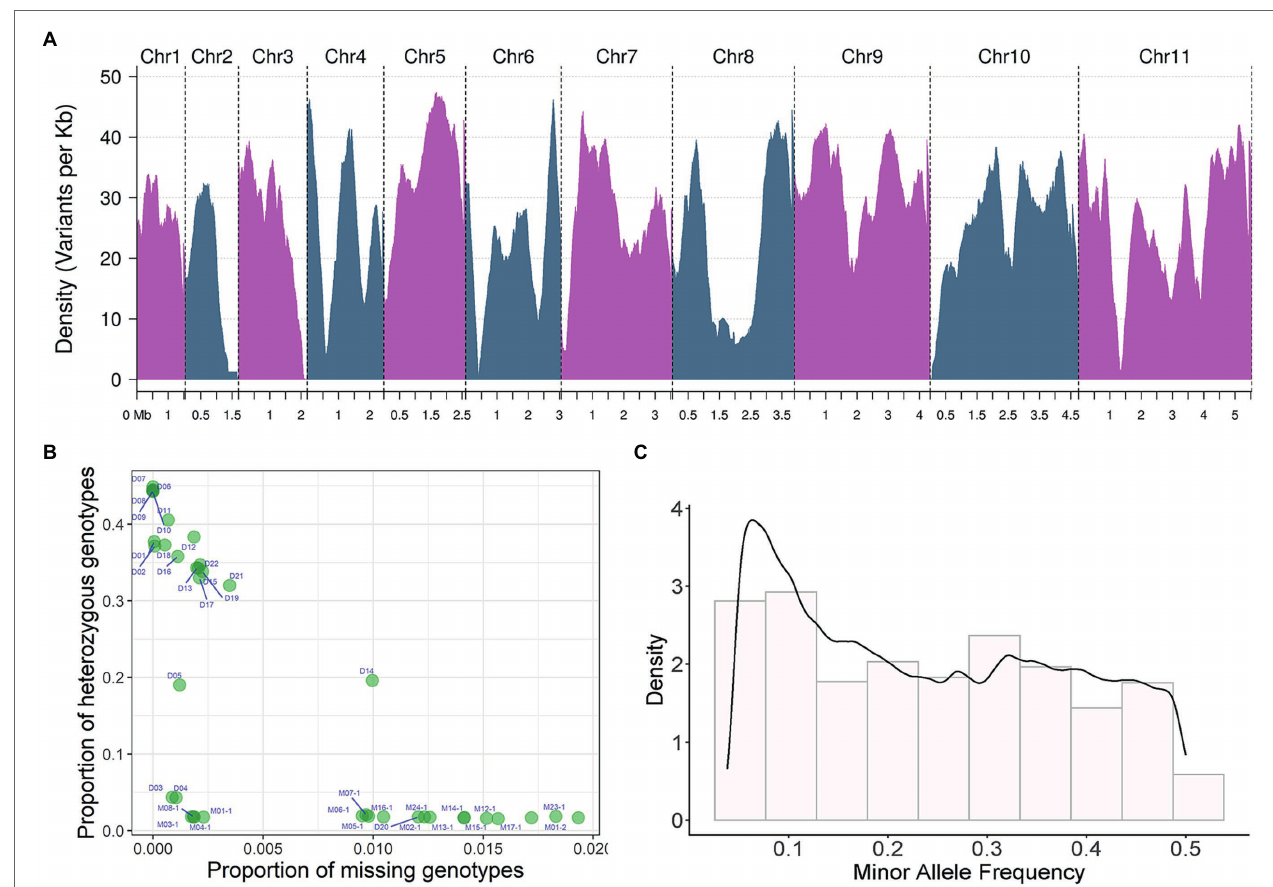
FIGURE 2 | SNP detection and joint genotyping results analysis of 39 sequenced strains. (A) Bi-allelic SNP marker density on 11 chromosomes. Density changes of 11 bi-allelic SNP markers on chromosomes. The density of variants per Kb is displayed on the y-axis, the x-axis shows the different chromosomes and their corresponding sequence sizes. Density is the distribution Density of the index recorded on chromosomes, in unit of marker number per KB. Density in (C) is the probability Density. The area under the curve is the probability. (B) The proportion of missing and heterozygous genotype of each resequenced strain analyzed by quality control (QC) analysis, the proportion of missing genotypes is shown on the x-axis, The proportion of heterozygous genotypes is shown on the y-axis. (C) Minor allele frequency (MAF) of bi-allelic